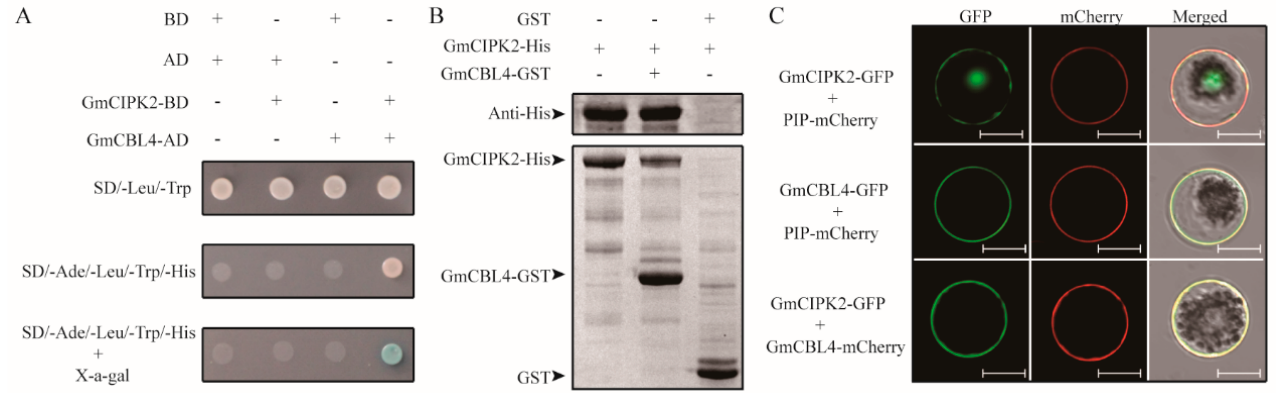
Figure 5. GmCBL4 is a GmCIPK2-interacting sensor. ( A ) Interaction analysis of GmCIPK2 and GmCBL4 by yeast two-hybrid assay. Transformed yeast cell ( AH109 ) containing GmCIPK2 -BD and GmCBL4 -AD was grown in SD/-Ade/-Trp/-His/-Leu medium containing X- α -gal. ( B ) Interaction analysis of GmCIPK2 and GmCBL4 by pull-down assay. The Western blotting assay showed that GmCIPK2-His was associated with GmCBL4-GST, unlike the control GST protein. ( C ) Subcellular localization analysis of GmCIPK2 and GmCBL4 in Arabidopsis protoplasts. Images were observed under a laser scanning confocal microscope. Bar = 10 µm.3.6. GmCBL4 Overexpression Imparts Salt Tolerance of Soybean Hairy Roots.